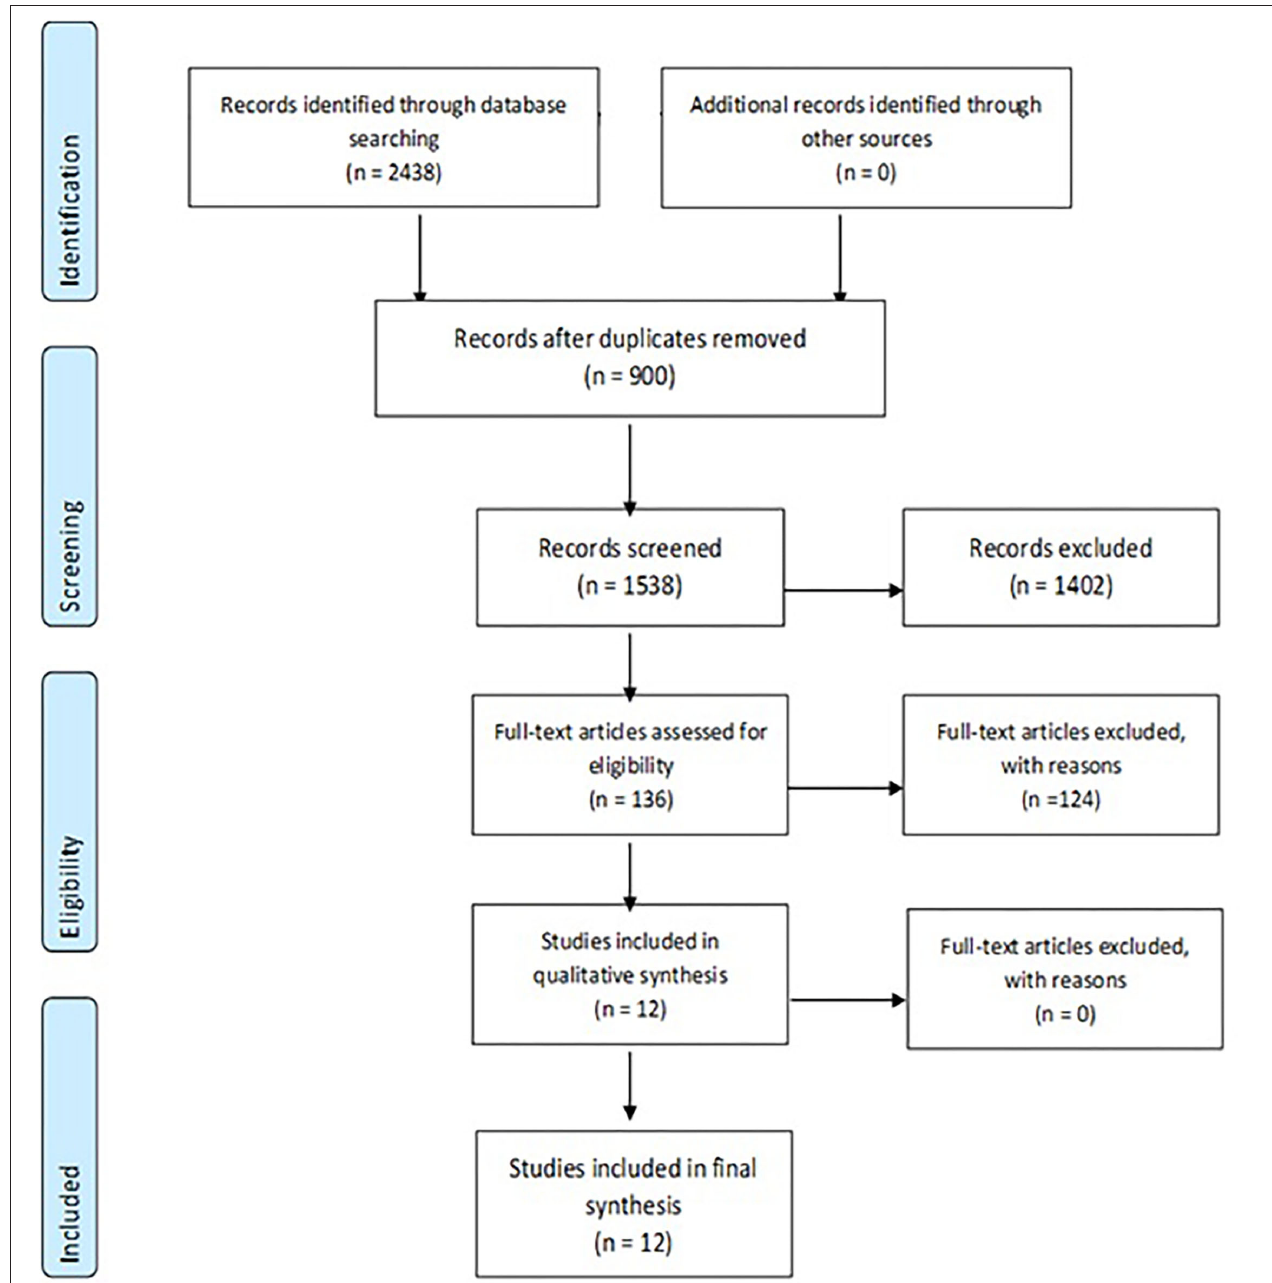
FIGURE 1 | The PRISMA flow diagram of the work